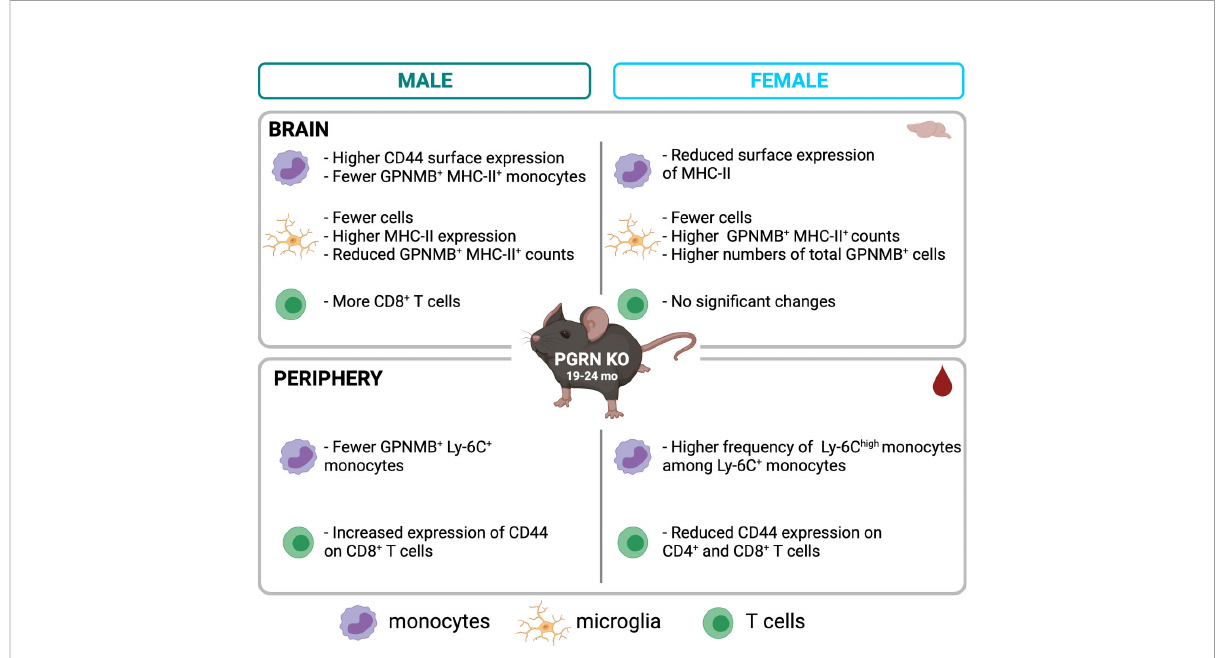
FIGURE 5 Summary of main fi ndings by fl ow cytometry in aged PGRN KO mice compared to WT. Created with